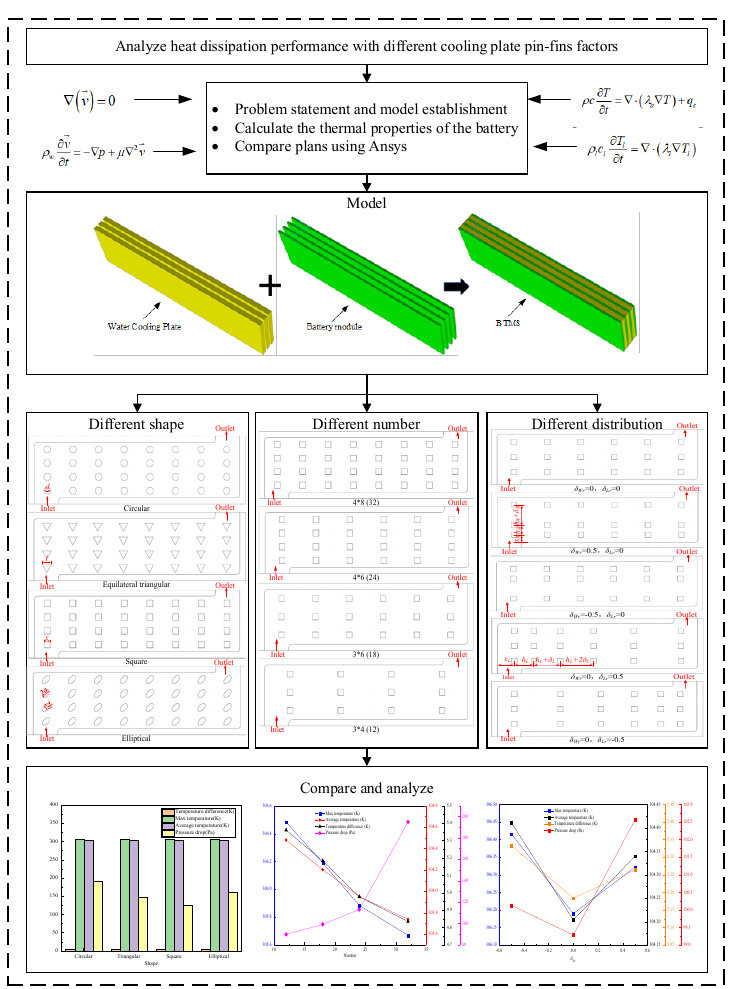
Figure 4. The research flowchart.